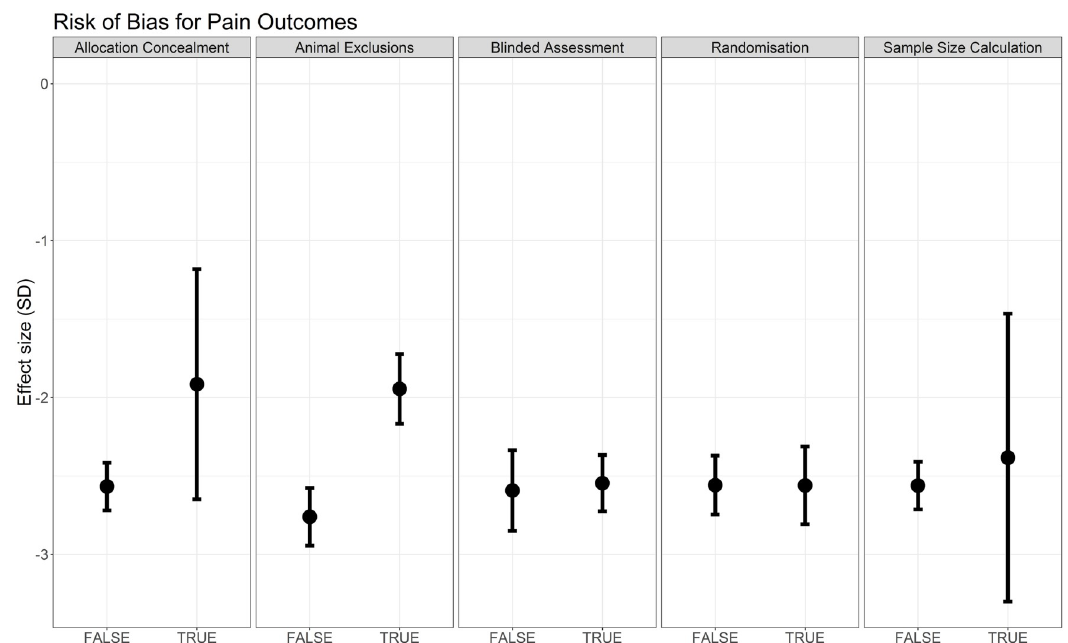
Fig 6. Effect sizes associated with measures to reduce risk of bias in modelling experiments using pain-related behavioural outcomes (data set 1a).